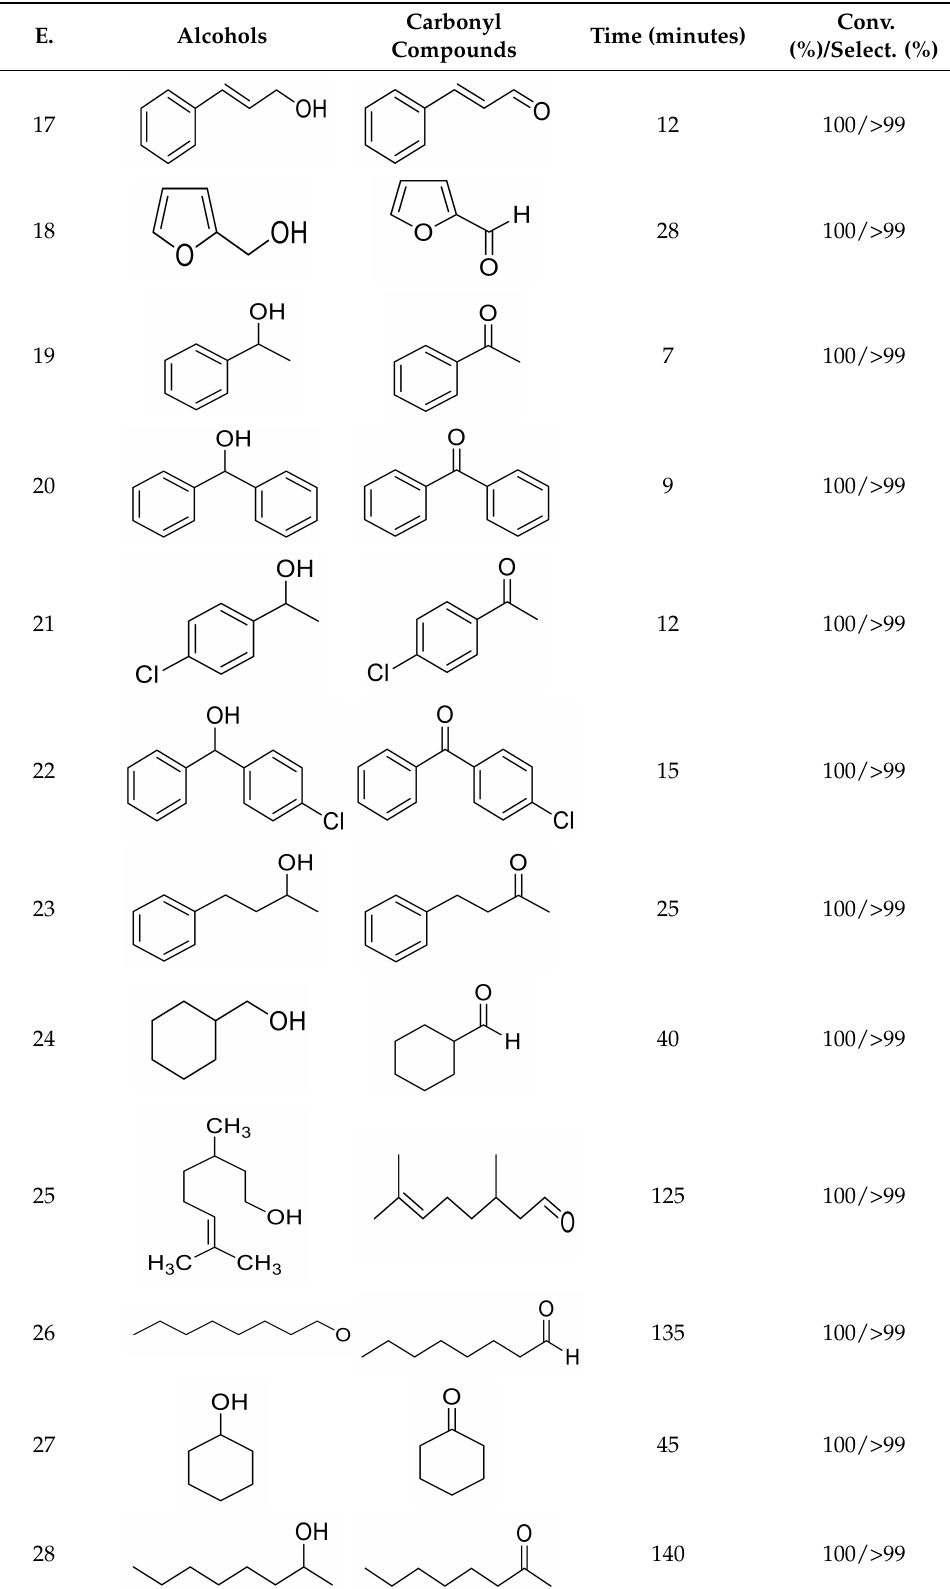
Table 4. Cont. E. Alcohols